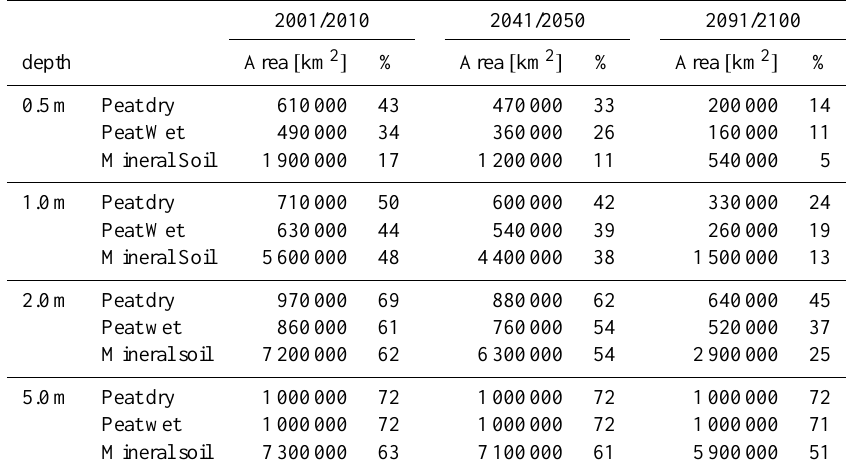
Table 4. 10-year average peatland areas underlain by permafrost at different depths (2 significant figures). Percentages are computed relative